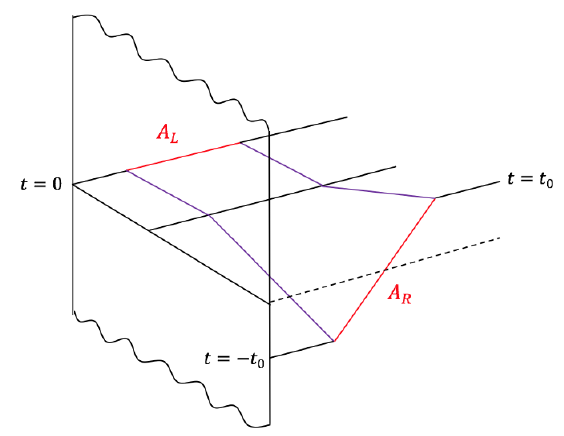
Figure 6. Situation when the constraint surface has two di(cid:11)erent boost angles and thus it is di(cid:11)erent from (cid:22) S R ( A